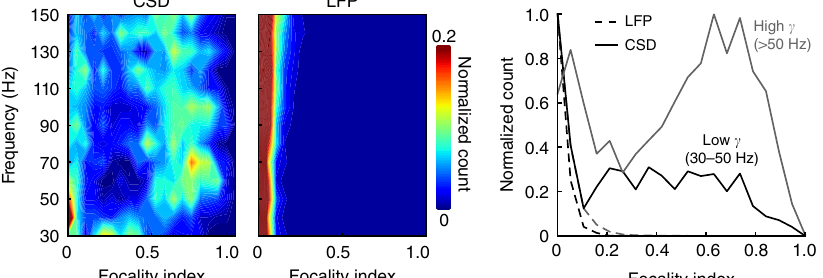
Fig. 1 Focal gamma bursts emerge in the dentate gyrus of freely moving mice. a Electrode tracks of the silicon probe used for LFP recording (shank spacing: 250 – 400 µ m, electrode pitch: 25 – 100 µ m, 8 – 16 recording sites/shank). Insets on the right show raw LFP traces recorded at the sites indicated. The position of the recording sites was determined post hoc (see “ Methods ” ). Scale bar 400 µ m. b Schematic illustration of the method used to quantify the focality of gamma oscillations. For each gamma epoch detected on recording sites A and B within the dentate gyrus granule cell layer (gcl) on neighboring shanks, we measured a focality index, which ranges theoretically from 0 (equal gamma power on both recording sites A and B) to 1 (total gamma power located on one of the recording sites A or B). c Gamma- fi ltered (30 – 150 Hz) LFP (top) and the resulting CSD traces (bottom) of recordings in the gcl at 250 µ m shank spacing. Note that the CSD reveals epochs of local gamma activity on one shank (brackets) while no difference in gamma amplitude is apparent when considering LFPs. d 2D histogram of focality index as a function of gamma frequency for CSD (left) and LFP (right). High focality indices are observed at frequencies above ~50 Hz in CSD but not LFP traces. In CSD recordings, for frequencies < 50 Hz focality indices are mostly < 0.1. e Normalized histograms of focality indices of low gamma (30 – 50 Hz, black) and high gamma (50 – 150 Hz, gray) epochs. Data are from N = 4